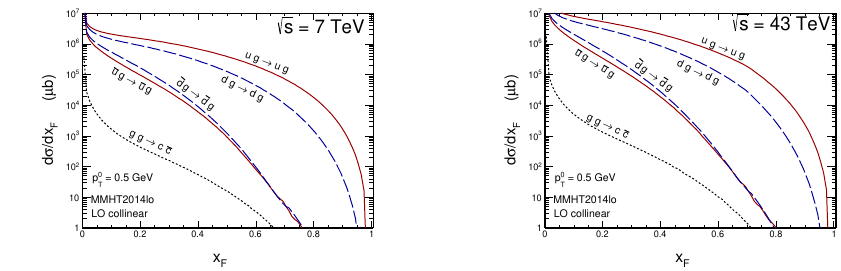
√ √ s = 7 TeV (left panel) and s = 43 = 0.5 GeV T